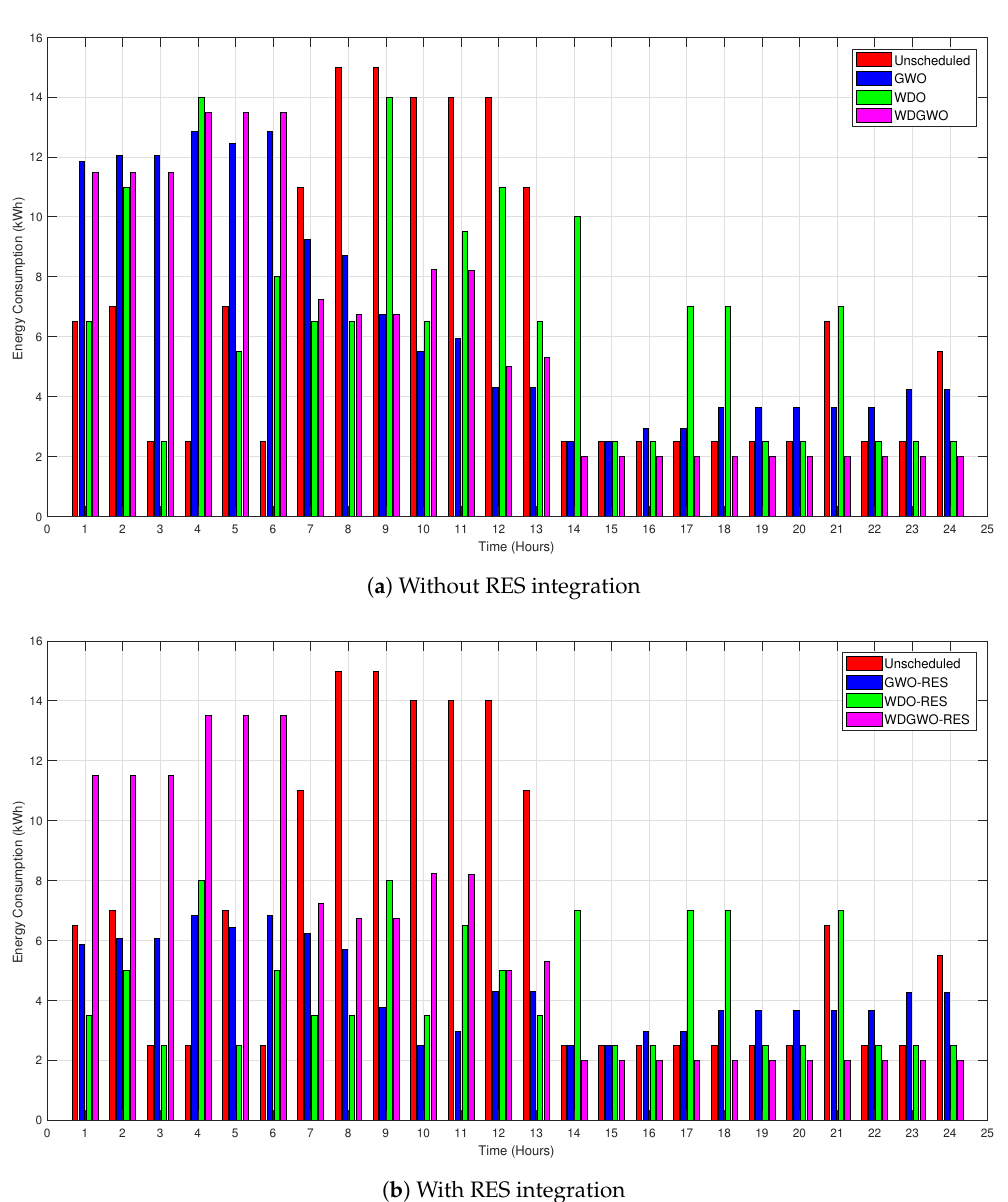
Figure 5. Energy consumption profile by